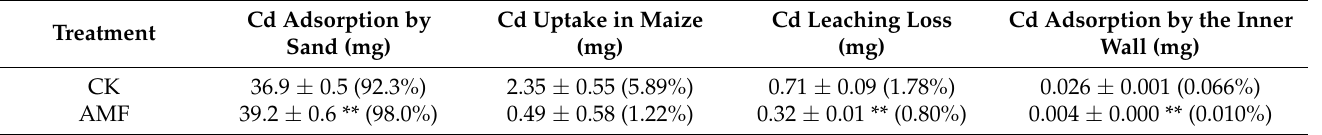
Table 3. Effect of AMF on Cd distribution in sand column maize system.